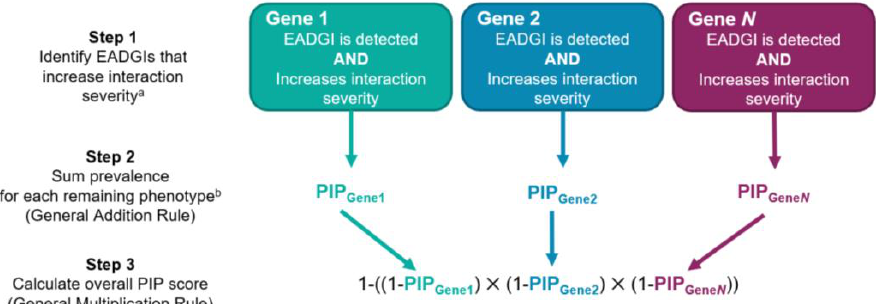
Figure 1. Workflow for calculating PIP scores. a The ability to detect the presence of an increased interaction severity for any EADGI or to identify any EADDGIs and EADGGIs is based on the YouScript knowledge base and patents [14]. b Only phenotypes such as ultrarapid metabolizer, intermediate metabolizer, or poor metabolizer with an increased interaction severity, are included in Step 2.